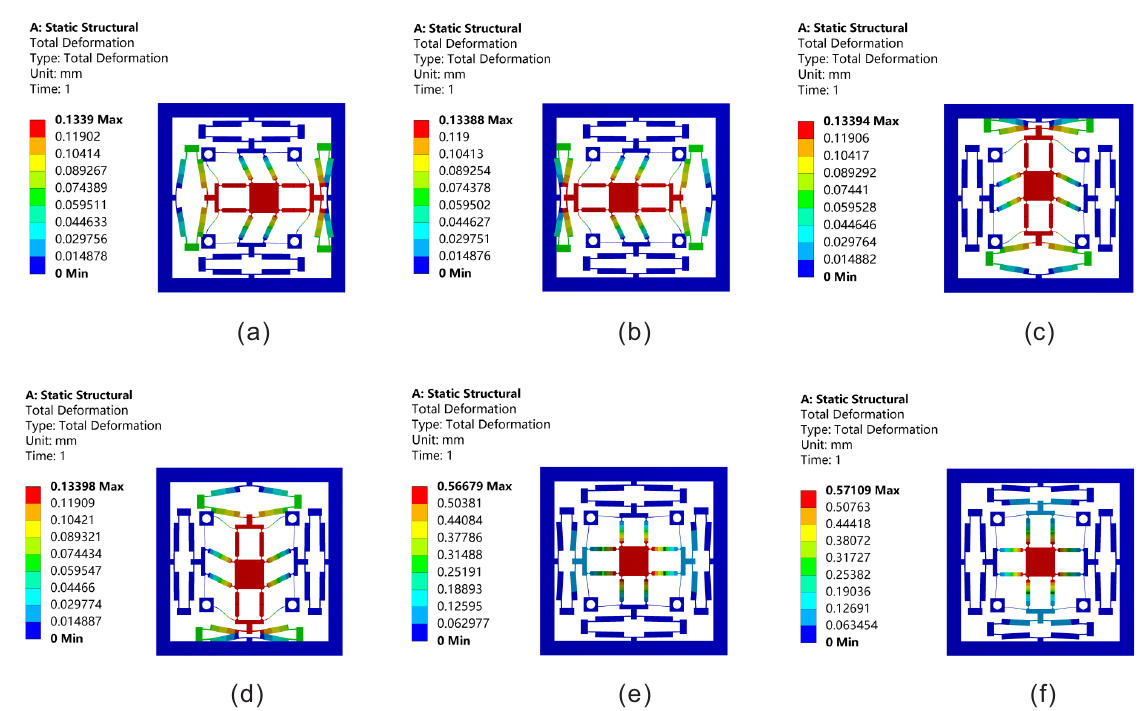
Figure 11. Total displacements along the XYZ three directions: ( a ) along X-axis positive direction; ( b ) along X-axis negative direction; ( c ) along Y-axis positive direction; ( d ) along Y-axis negative direction; ( e ) along Z-axis positive direction; ( f ) along Z-axis negative direction.